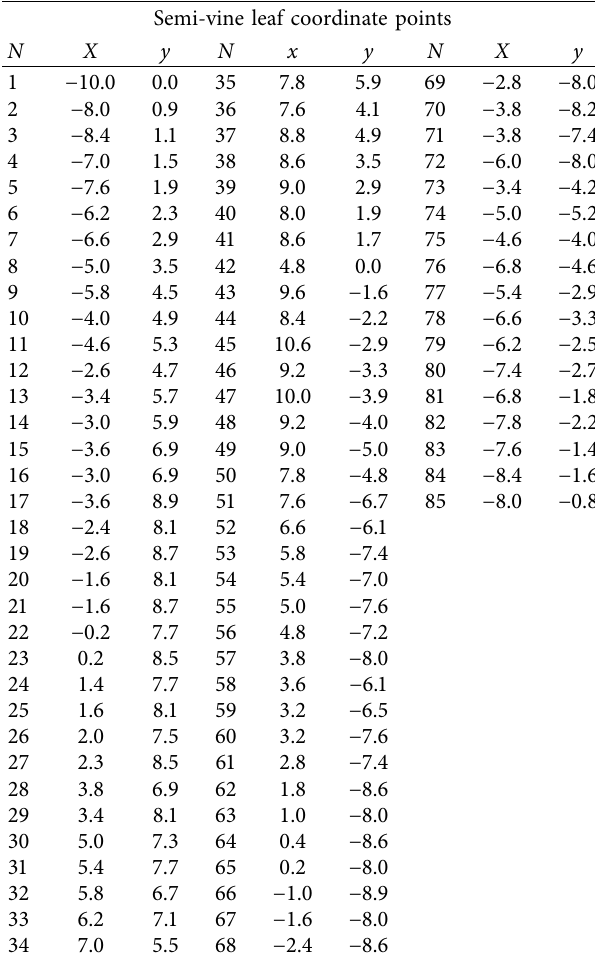
Figure 2: Vine leaf shape realization procedure: (a) the initiator circular patch; (b) the realized vine leaf shape. Table 1: The point coordinates of the proposed Vitis vinifera leaf- shaped radiating FR4 substrate